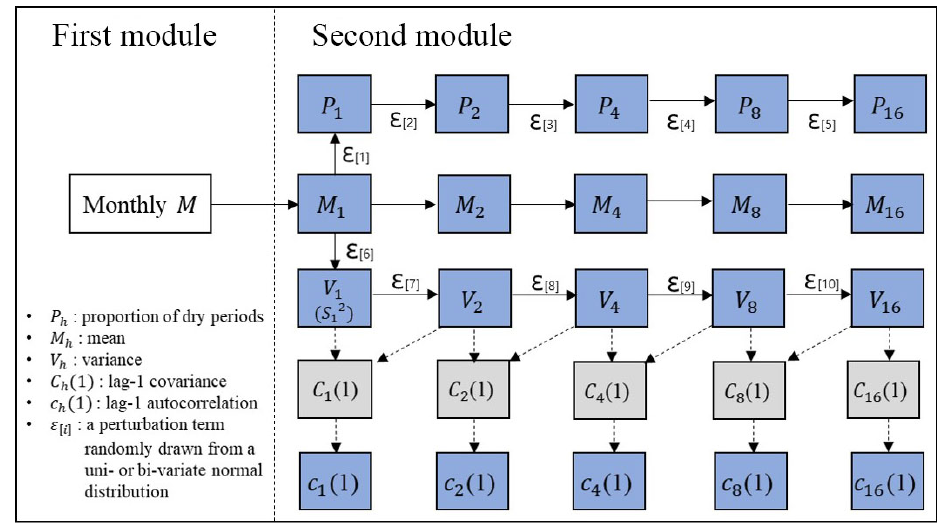
Figure 5. Schematic of the algorithm to generate fine-timescale rainfall statistics. The statistics in the blue boxes are used to calibrate the MBLRP model and the statistics in grey boxes are used to estimate the lag-1